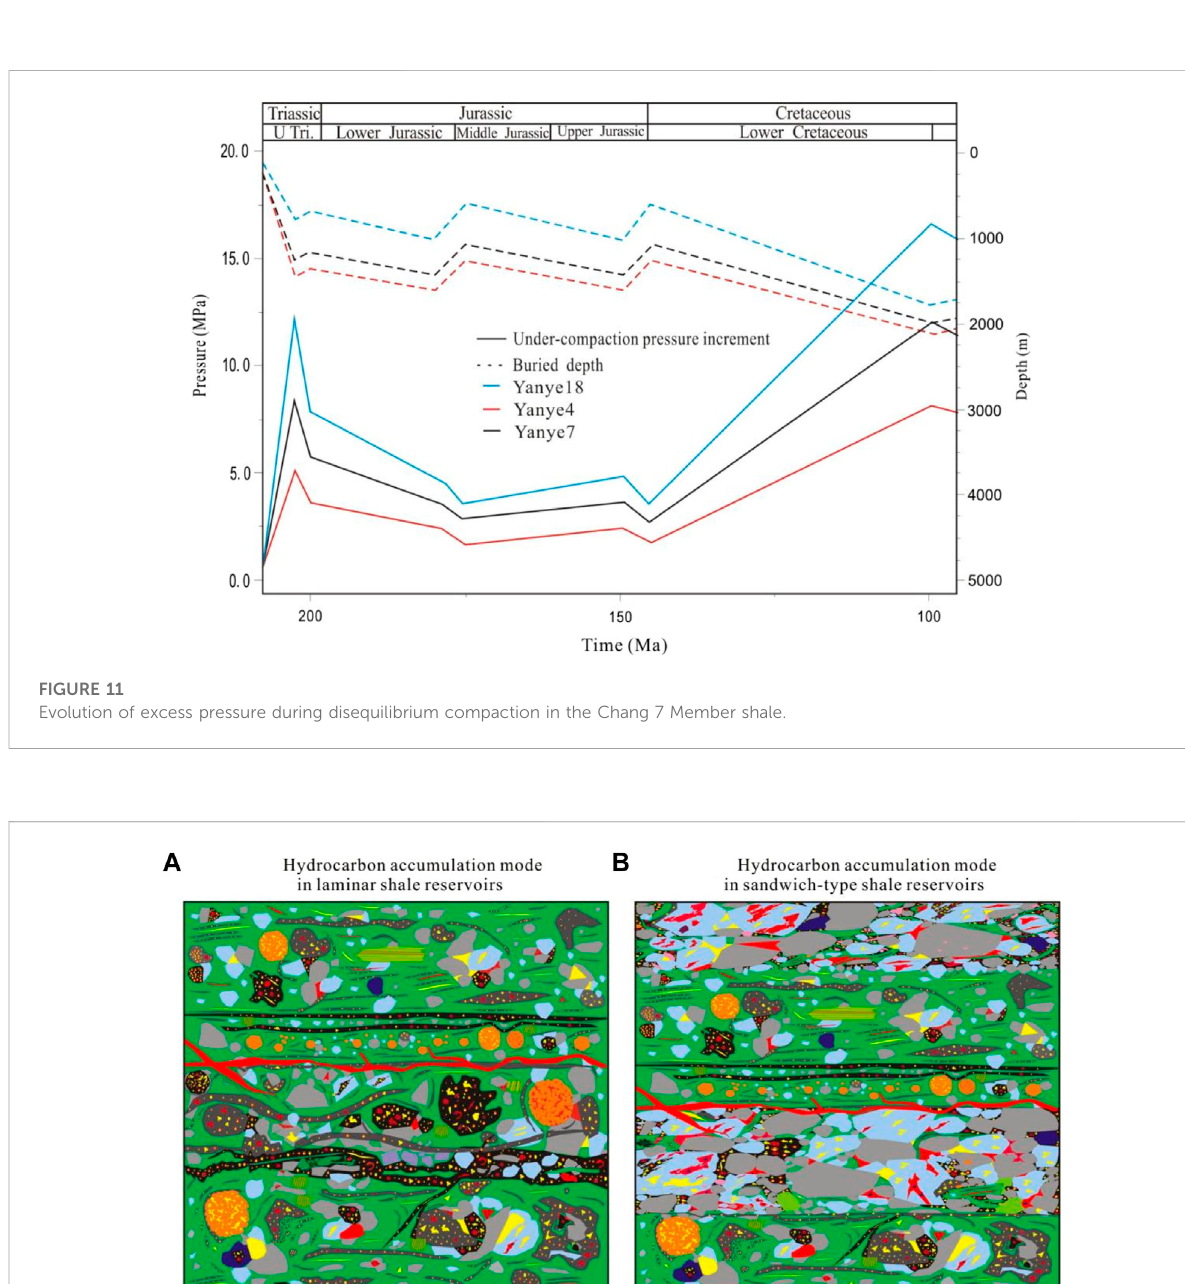
Frontiers in Earth